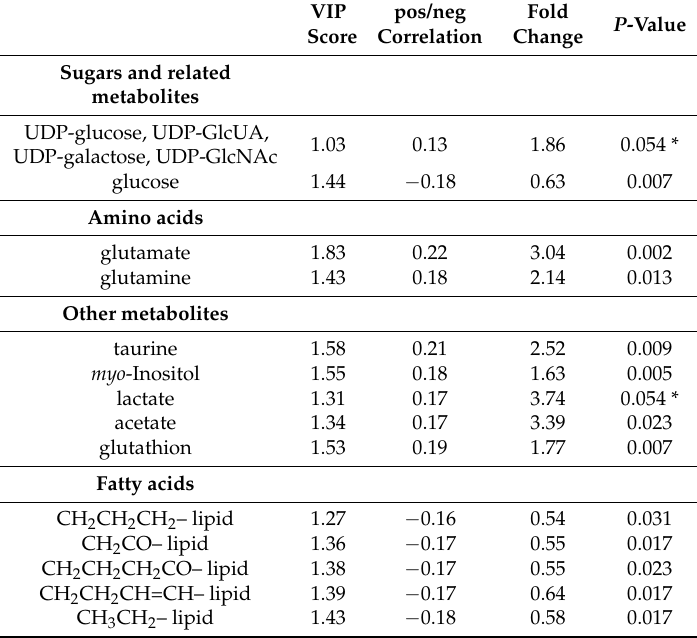
Table 2. NMR analysis of cardiac tissue from patients with hypertrophic cardiomyopathy (HCM) (n = 5) compared to healthy controls’ left wall and septum (n = 10). The variable importance in projection (VIP) score and fold change of metabolites with significant difference between HCM and non-failing left chamber wall. VIP